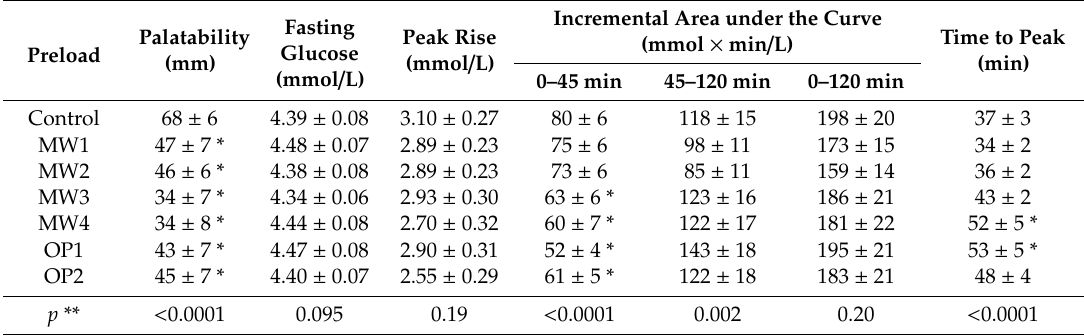
Table 2. Palatability, fasting glucose, and measures of glycemic